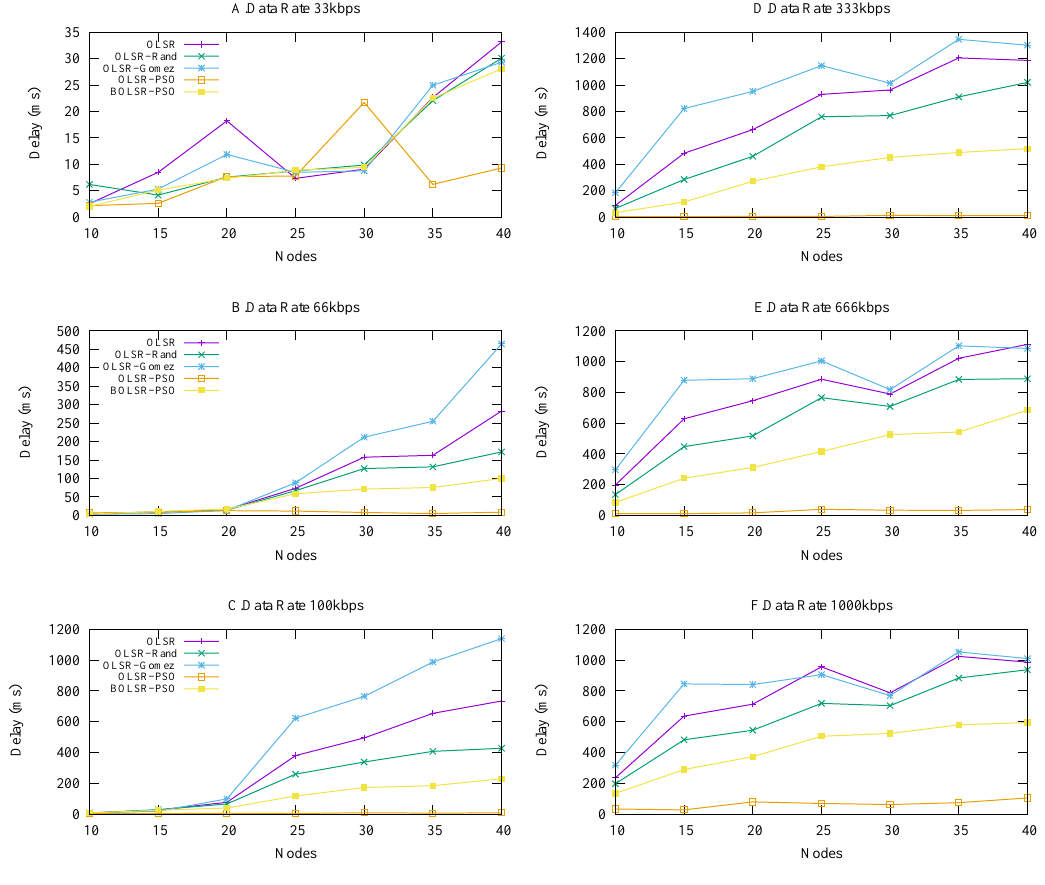
Figure 9. End-to-end Delay vs. Number of Nodes. Table 8. Statistical Result of Delay Performance